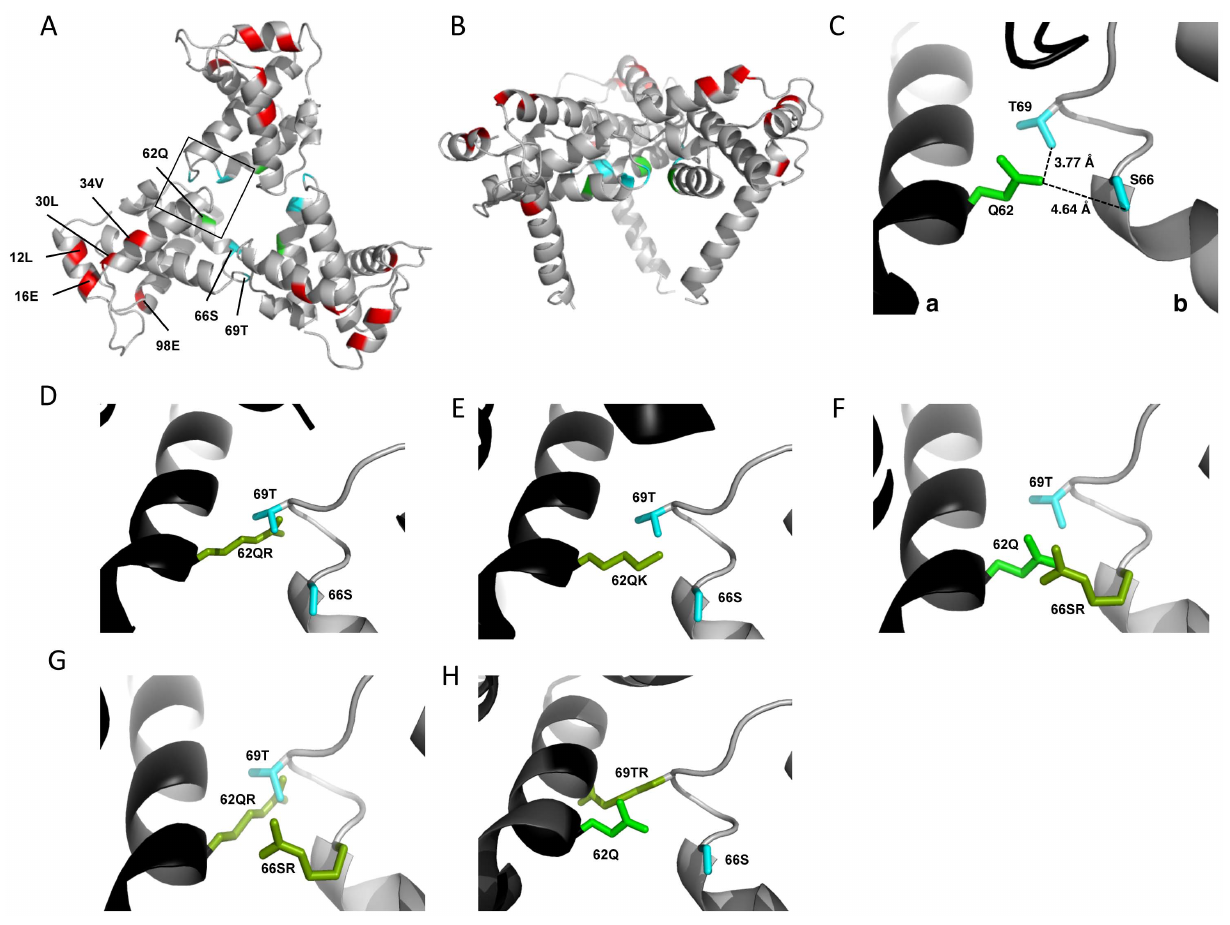
Figure 6. Potential for intersubunit interactions in the MA trimer. MA trimer as described in Hill et al. PNAS (1996), showing (A) a top-down view and (B) a side-on view [32]. Env incorporation defects, red; Q62, green; Ser66 and Thr69, cyan. (C) Close-up view of boxed area from (A), showing Q62 side chain (green), and the side chains of S66 and T69 (cyan) of a second MA monomer. Chain a, black; chain b, gray. Distances between the oxygen atoms of Q62 carbonyl group and the S66 and T69 hydroxyl groups are indicated. Modeled configurations for R62 (D) K62 (E), R66 (F), R66, in combination with R62 (G) and R69 (H). Mutagenesis and rendering performed using MacPymol [70].